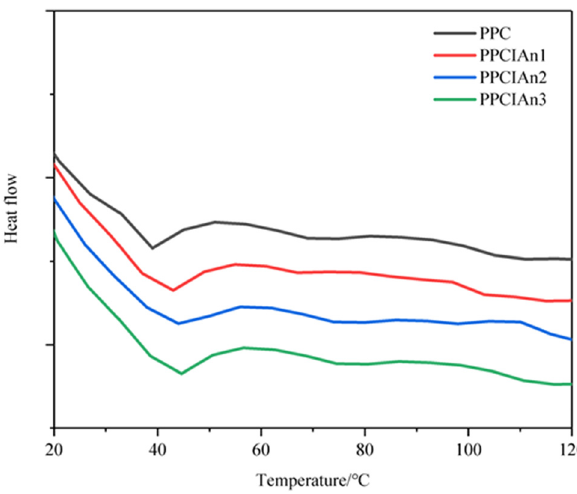
Figure 4: DSC analysis curves of copolymers PPC and PPCIAns.